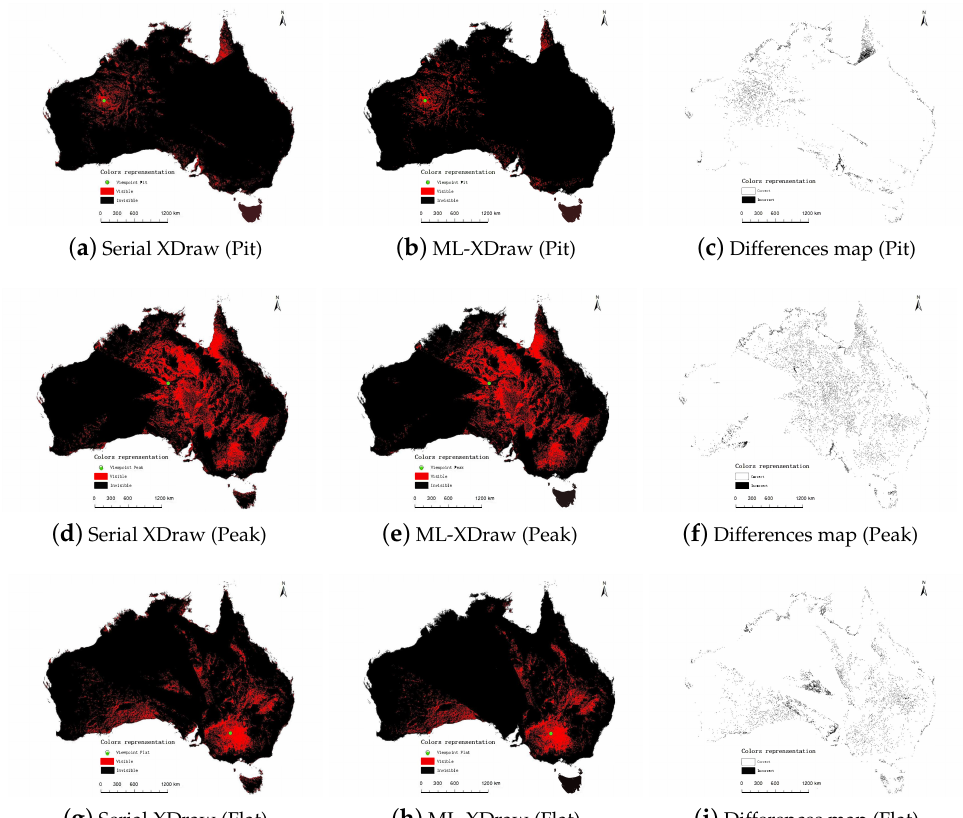
Figure 10. Viewshed result maps generated by two algorithms based on dataset DEM3. ( a , d , g ) are the calculation results of serial XDraw algorithm. ( b , e , h ) are the calculation results of ML-XDraw algorithm. ( c , f , i ) are the differences maps of the two algorithms’